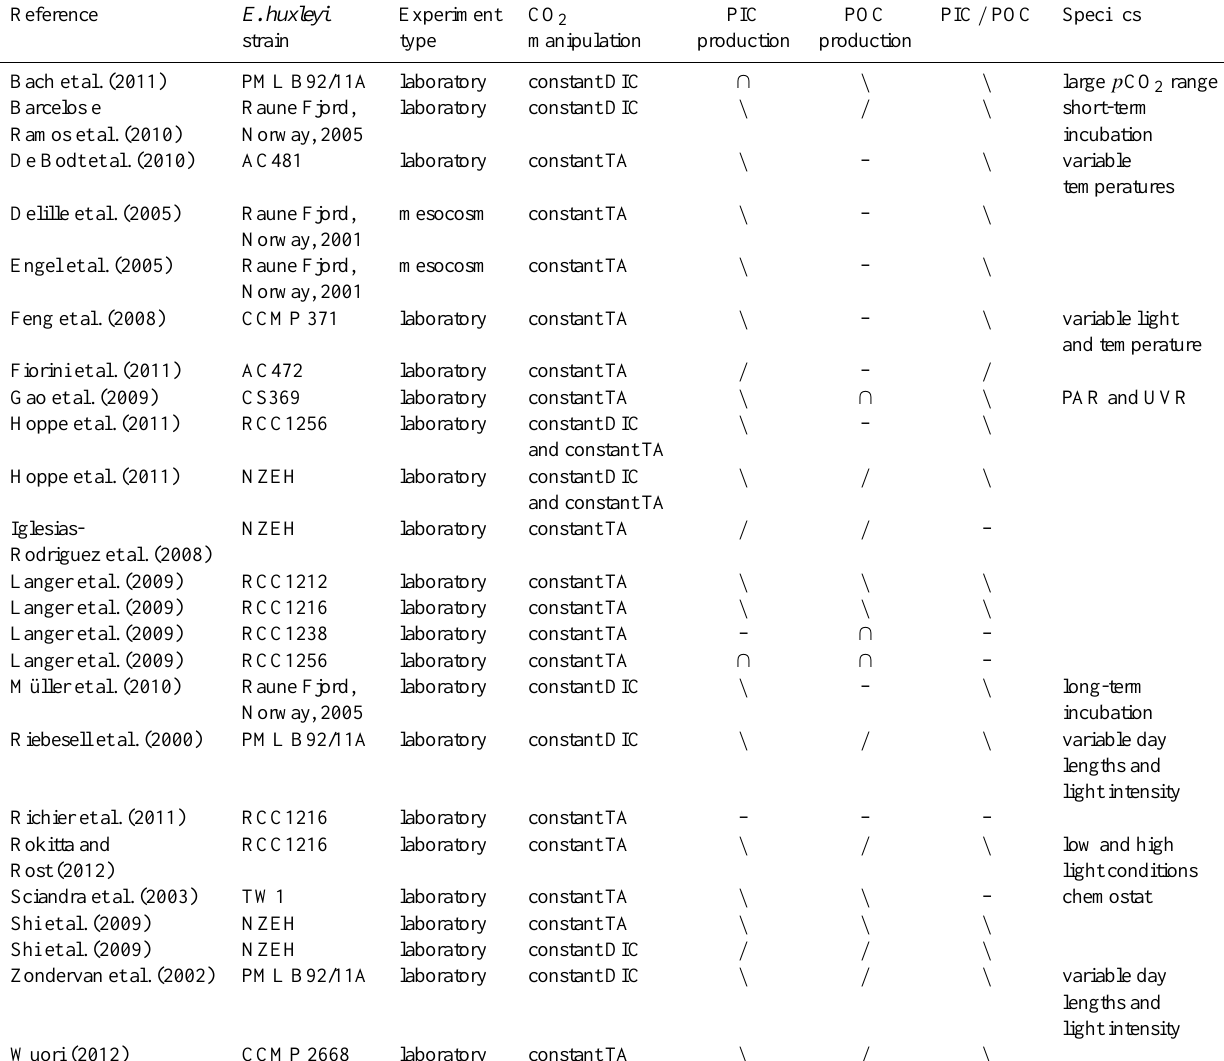
Table 1. Summary of the available carbonate chemistry manipulation experiments and the responses of Emiliania huxleyi as reported by the authors of those studies. Symbols: – no response; / increased response; ∩ nonlinear response; \ decreased